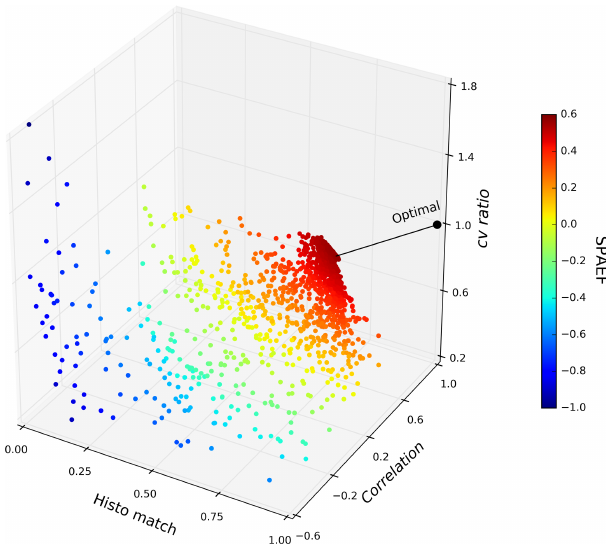
Figure 6. 3-D Pareto front based on the 2500 runs during the SPAEF optimization. Each component of the SPAEF metric represents an individual axis. The black line indicates the deviation between the theoretical optimal (1 , 1 , 1) SPAEF value and the optimized model run (0 . 72 , 0 . 73 , 0 .